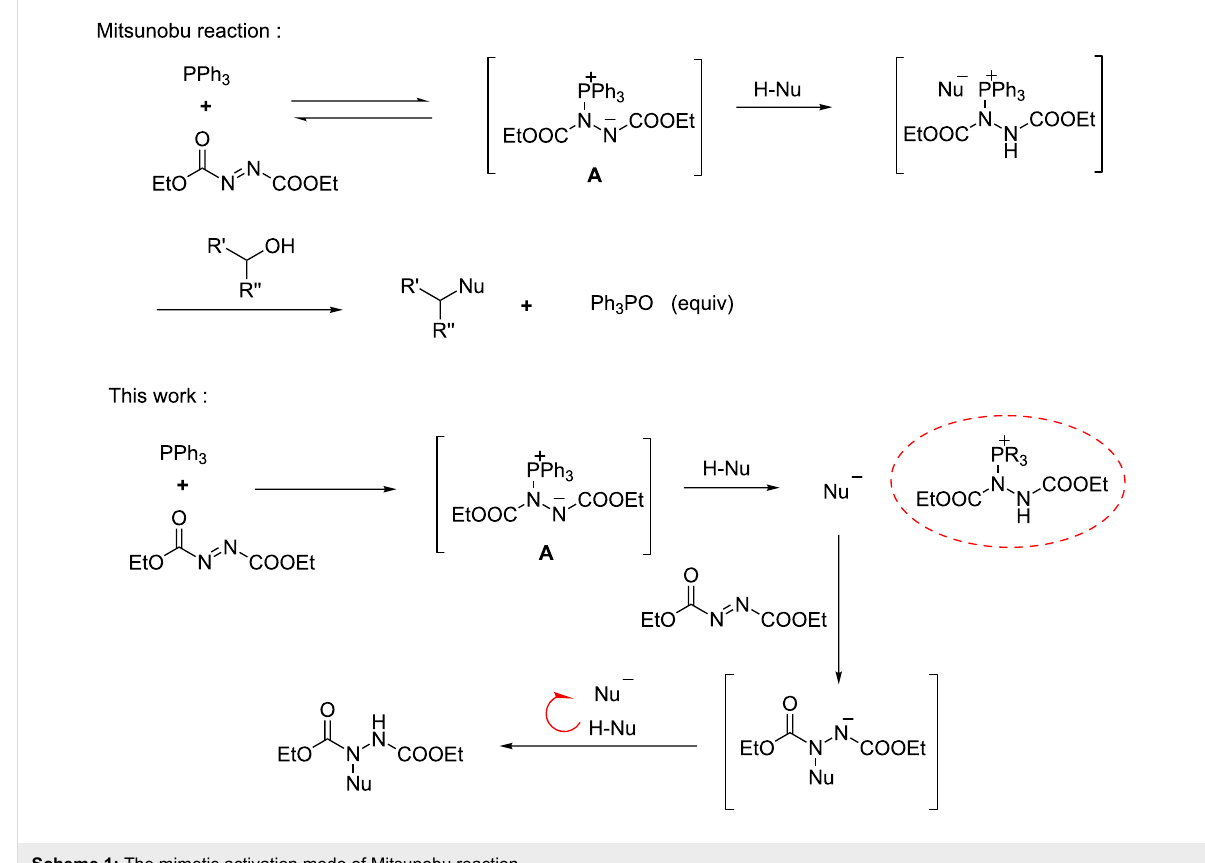
Scheme 1: The mimetic activation mode of Mitsunobu